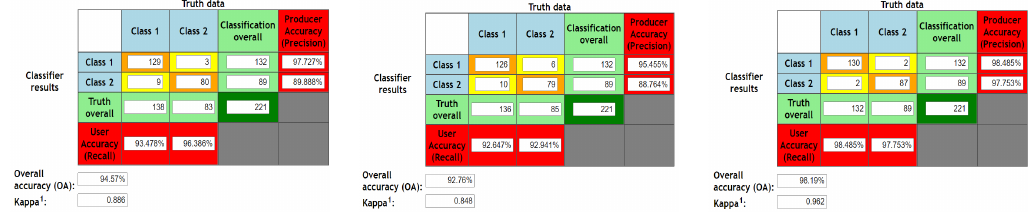
Figure 10. Confusion matrix for 5 fold cross validation of 2D images for SVM, LSTM and VAE-CNN respectively.